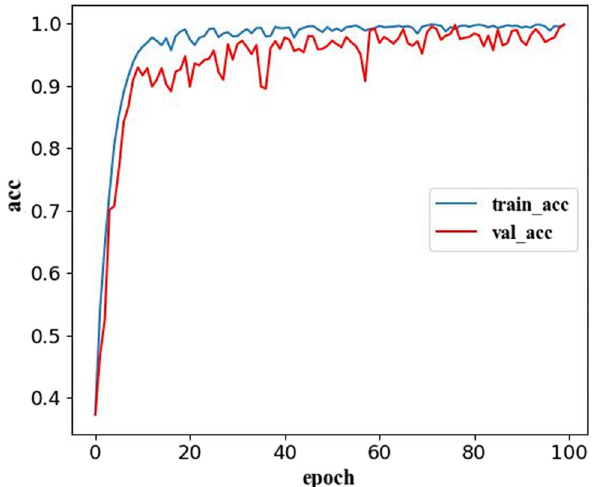
Fig. 7 Training and validation accuracy on training the